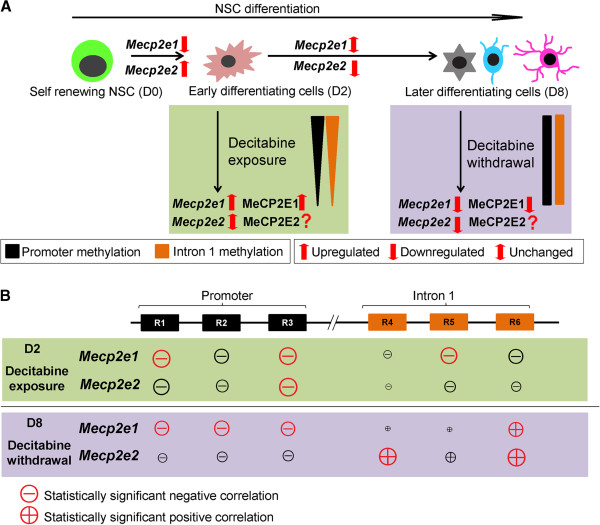
Summary of the correlations between the expression of Methyl CpG binding protein 2 gene (Mecp2) isoforms and DNA methylation at the Mecp2 regulatory elements. (A) Dynamic changes in the expression of Mecp2 isoforms (Mecp2e1 and Mecp2e2) at different time points of neural stem cell (NSC) differentiation at day 0 (D0), D2 and D8. Decitabine caused upregulation of Mecp2e1/MeCP2E1 but not Mecp2e2 at D2. Decitabine effect on MeCP2E2 at the protein levels is unknown. Decitabine withdrawal by D8 downregulated Mecp2e1/MeCP2E1, and Mecp2e2/MeCP2E2 (unknown) to different extents. (B) Schematic representation of the correlation between Mecp2 isoform-specific expression and DNA methylation at the Mecp2 promoter regions (R1 to R3), and intron 1 regions (R4 to R6). The size of the signs, plus (+), and minus (-) represents the relative degree of correlation with either Mecp2 isoform. The statistically significant correlations are represented in red (red-circled plus, red-circled minus). After decitabine exposure Mecp2e1 expression negatively correlated with promoter R1 and R3, and intron 1 R5. Mecp2e2 isoform negatively correlates with promoter R3. In contrast, after decitabine withdrawal, Mecp2e1 expression negatively correlated with promoter R1, R2 and R3, and positively correlated with intron 1 R6. Hence, correlation between Mecp2e1 and DNA methylation at REs changed depending on the stage of NSC differentiation. Mecp2e2 isoform positively correlated with intron 1 R4 and R6.